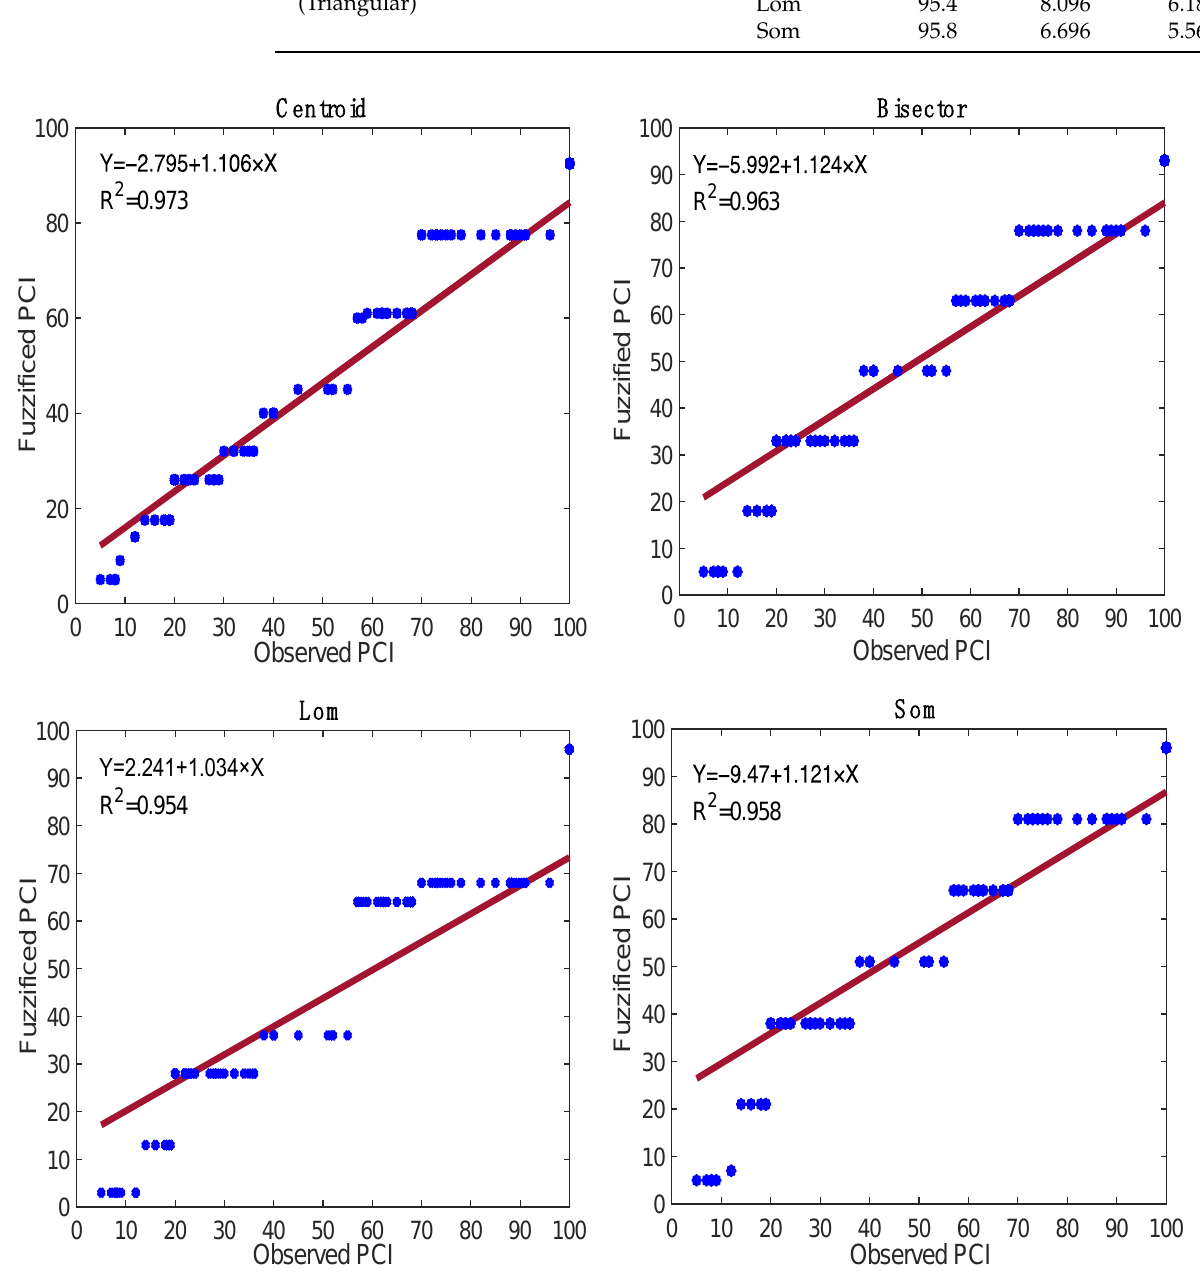
Figure 4. Performance of a fuzzy inference system-based PCI for 120 sections.